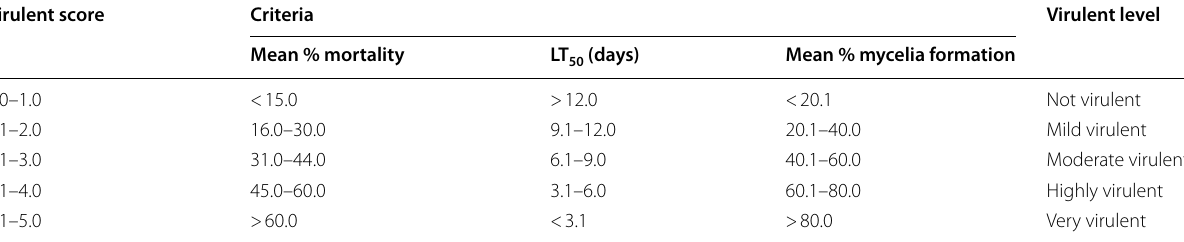
Table 1 Virulent score assessment for UPM EPF Virulent score Criteria Virulent level Mean % mortality LT 50